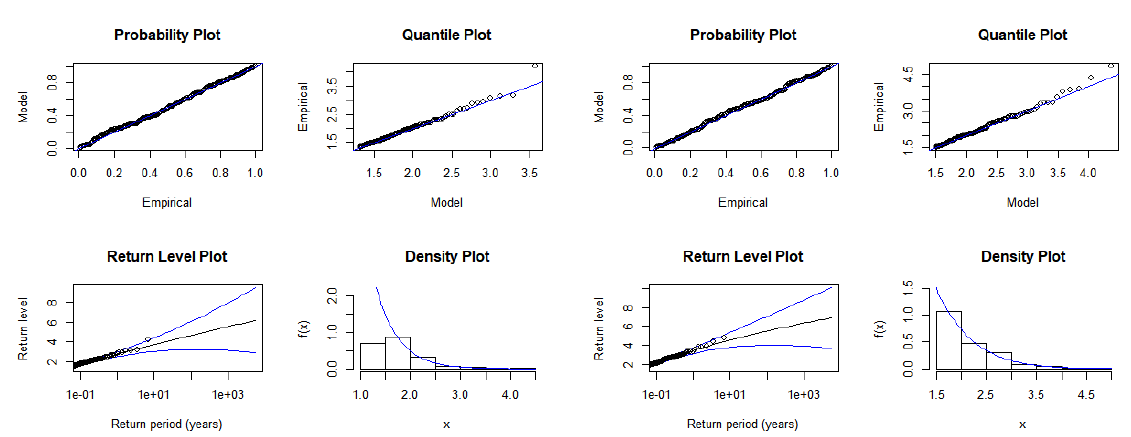
Figure 9. GPD positive ALSI residuals Figure 10. GPD negative ALSI residuals